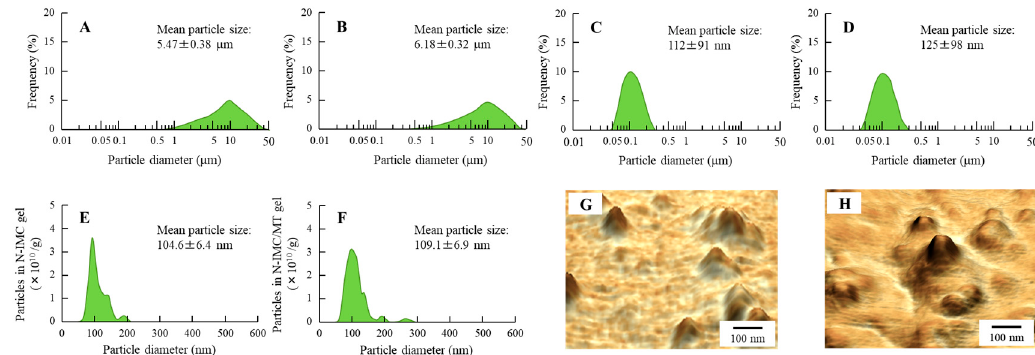
Figure 1. Particle analysis of N-IMC and N-IMC/MT gels immediately after the bead mill treatment. ( A ) and ( B ); the particle size frequencies in transdermal formulations containing indomethacin (IMC) powder (P-IMC, A ) and transdermal formulations containing IMC powder and l-menthol (P-IMC/MT, B ) gels by SALD-7100. ( C and D ); the particle size frequencies of N-IMC ( C ) and N-IMC/MT ( D ) gels by SALD-7100. ( E and F ); the particle size frequencies of N-IMC ( E ) and N-IMC/MT ( F ) gels by NANOSIGHT LM10. ( G and H ); atomic force microscope (AFM) images of N-IMC ( G ) and N-IMC/MT ( H ) gels by SPM-9700. The particle size of IMC was decreased to approximately 50–200 nm, and no differences were observed in the particle characterizations between the N-IMC and N-IMC/MT gels.